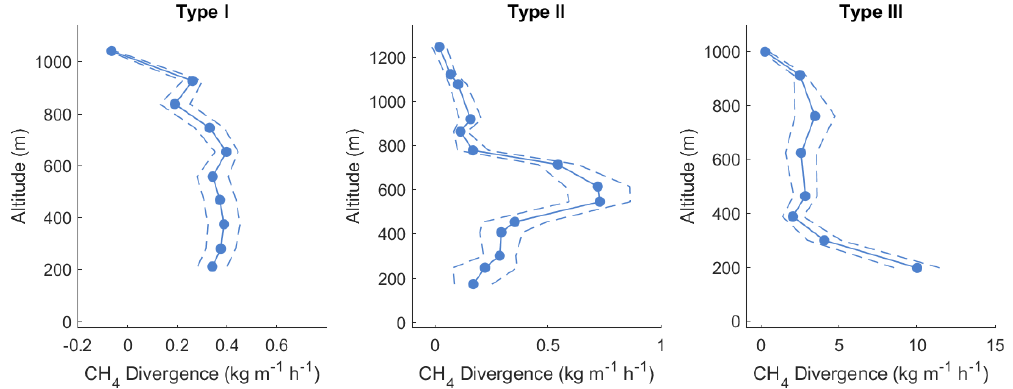
Figure 10. Sample data representing the three common types of flux divergence profiles for the SciAv method. Blue dots represent the flux divergence of each lap, with the associated uncertainty drawn as blue